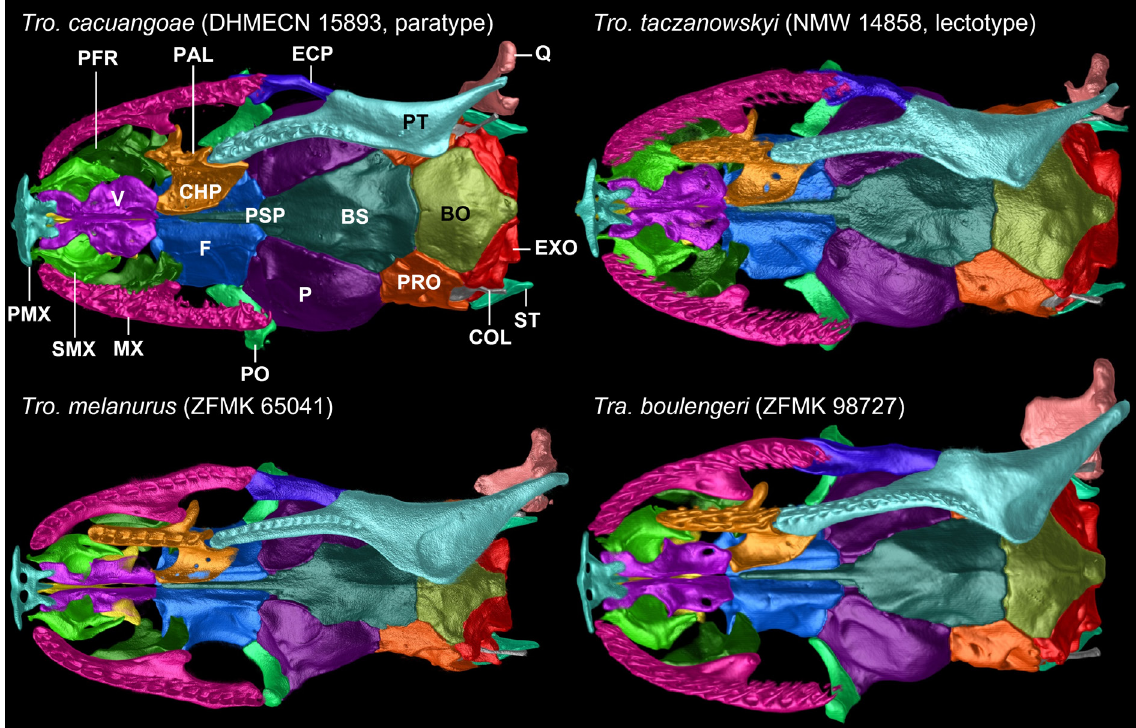
Fig. 12. Micro-CT images of the ventral view of the skulls of Tropidophis cacuangoae sp. nov., ♀ (DHMECN 15893, paratype), T. taczanowskyi (Steindachner, 1880) (NMW 14858, lectotype), T. melanurus (Schlegel, 1837) (ZFMK 65041), and Trachyboa boulengeri Peracca, 1910 (ZFMK 98727). Different skull elements are digitally colored and the mandibulae, and right palatine, pterygoid, ectopterygoid and quadrate are removed for better visualization. Abbreviations: BO = basioccipital; BS = basisphenoid; CHP = choanal process of palatine; COL = columella; ECP = ectopterygoid; EXO = exoccipital; F = frontal; MX = maxilla; P = parietal; PAL = palatine; PFR = prefrontal; PMX = premaxilla; PO = postorbital; PRO = prootic; PSP = parasphenoid rostrum; PT = pterygoid; Q = quadrate; SMX = septomaxilla; ST = supratemporal; V =